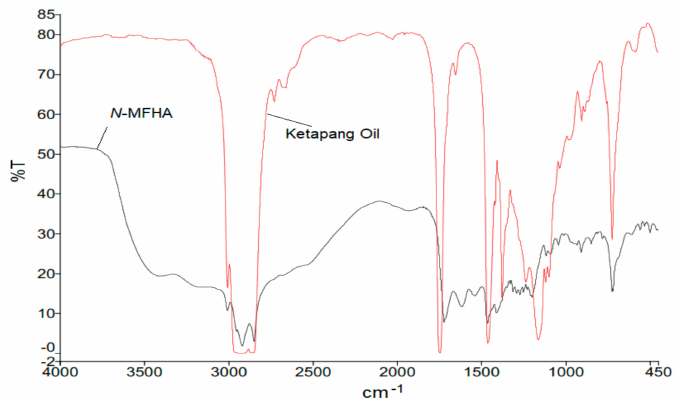
Figure 1. FTIR spectrum from ketapang oil and the products